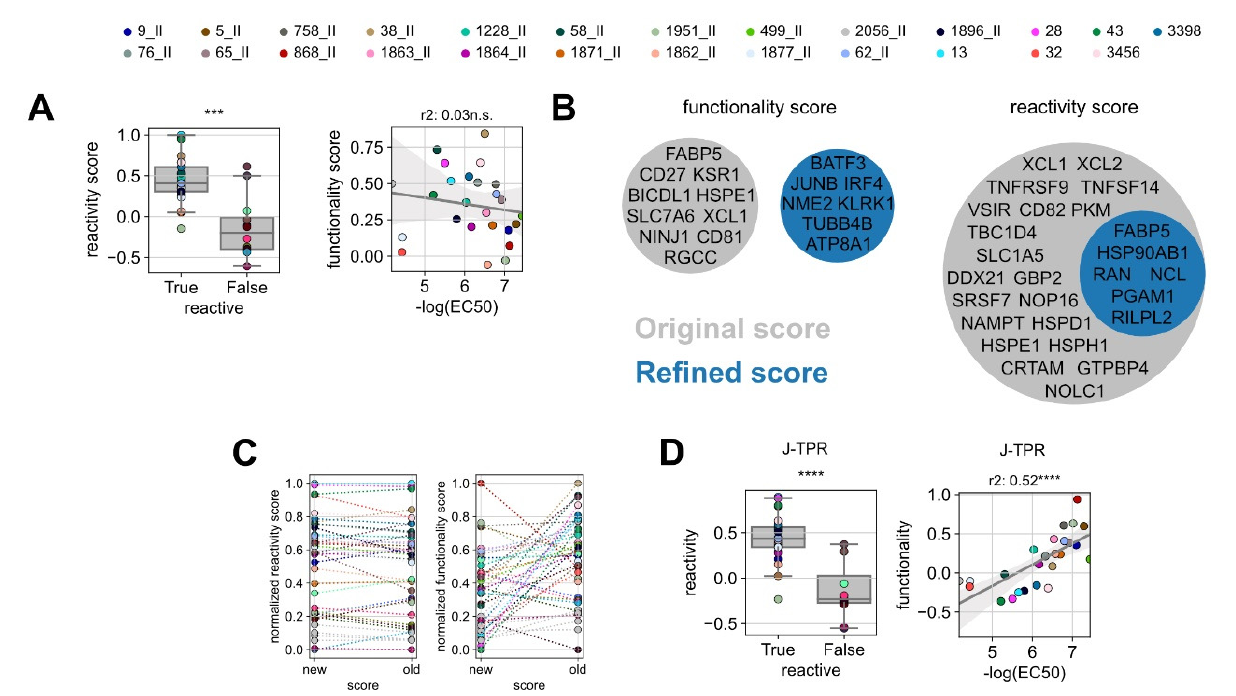
Figure 4. Improvement of the predictive precision of gene scores. ( A ) Box plot of the original reactivity score grouped into reactive and non-reactive TCRs (left) and linear regression analysis between in vitro functionality (NFAT EC 50 ) and ‘original’ functionality gene score for reactive TCRs (right). ( B ) Venn diagrams of the genes defining the ‘original’ and ‘refined’ functionality and reactivity scores. ( C ) Comparison of the original and refined scores for reactivity (left) and functionality (right). Statistical testing was conducted by Kruskal–Wallis H test. ( D ) Box plot of the refined reactivity score grouped into reactive and non-reactive TCRs (left) and linear regression analysis between in vitro functionality (NFAT EC 50 ) and ‘refined’ functionality gene score for reactive TCRs (right). Linear correlation analysis was performed by Pearson’s correlation. ns p > 0.05, *** p < 0.001, **** p < 0.0001.